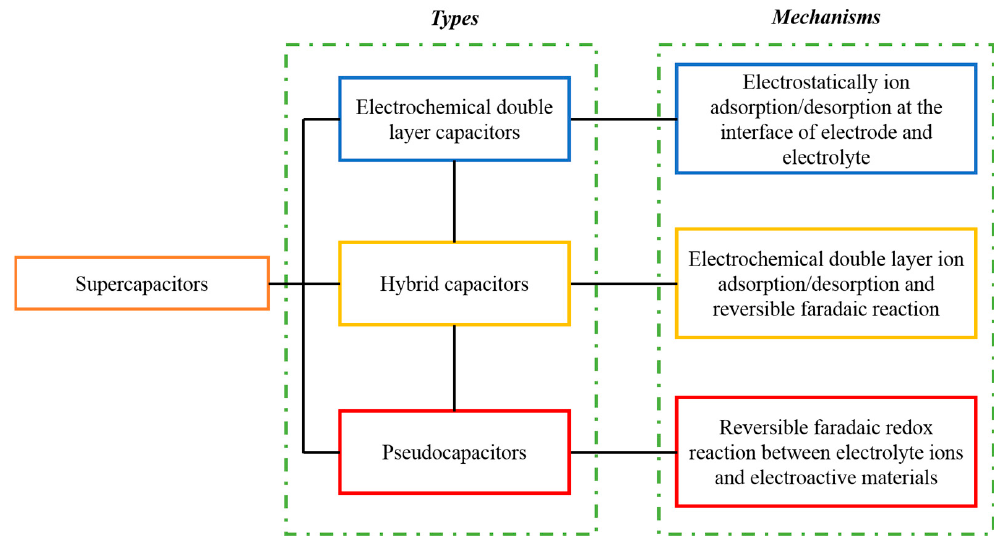
Figure 2. Types of electrochemical capacitors based on charge storage mechanism.